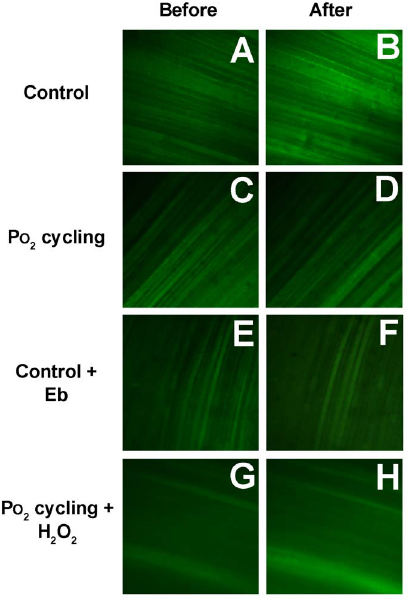
Figure 1. Representative ROS images from Hfluor-loaded diaphragm tissue. A: control muscle before 40 Torr PO 2 . B: the same area of A at the end of 40 Torr PO 2 . C: PO 2 cycling treated muscle before 40 Torr PO 2 . D: the same area of C at the end of 40 Torr PO 2 . E: Ebselen (Eb) treated muscle before 40 Torr PO 2 . F: the same area of E at the end of 40 Torr PO 2 . G: PO 2 cycling + H 2 O 2 treated muscle before 40 Torr PO 2 . H: the same area of G at the end of 40 Torr PO 2 .